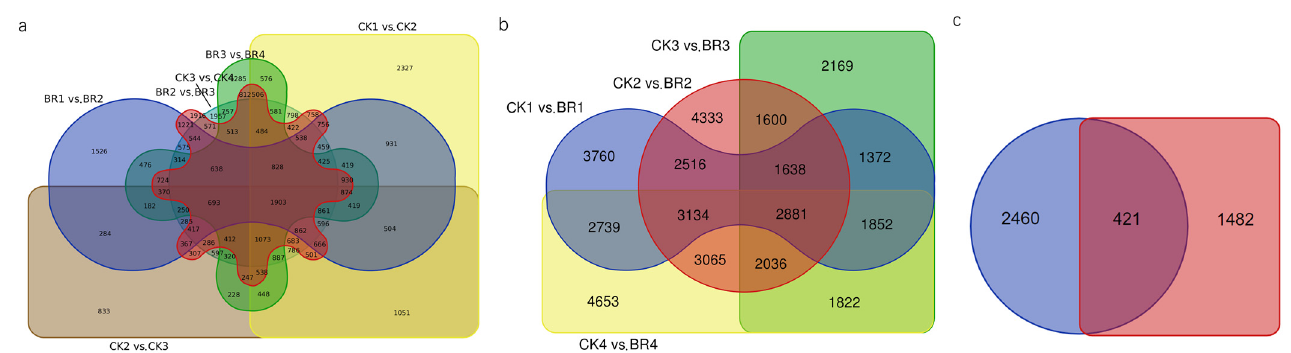
Figure 5. Venn diagrams of differentially expressed genes: ( a ) Venn diagram of differentially ex- pressed genes at different flowering periods in CK group and BR group; ( b ) Venn diagram of differentially expressed genes in CK group vs. BR group; ( c ) Venn diagram of differentially expressed genes, combining analyses from ( a , b ).